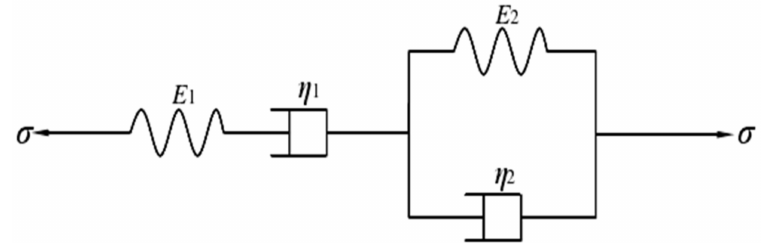
Figure 2. Burgers